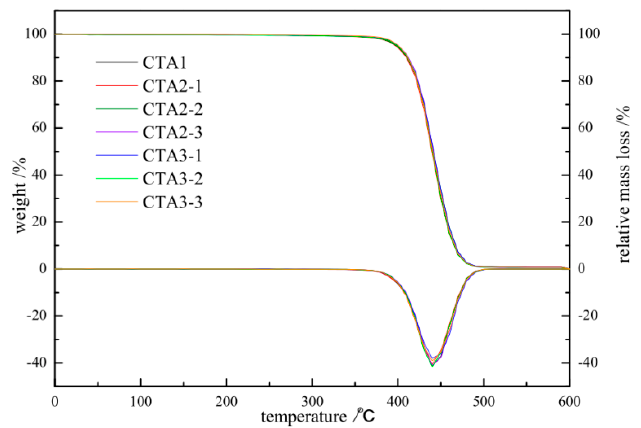
Figure 2. TGA/DTA of ABS resin obtained using different chain transfer agents at different